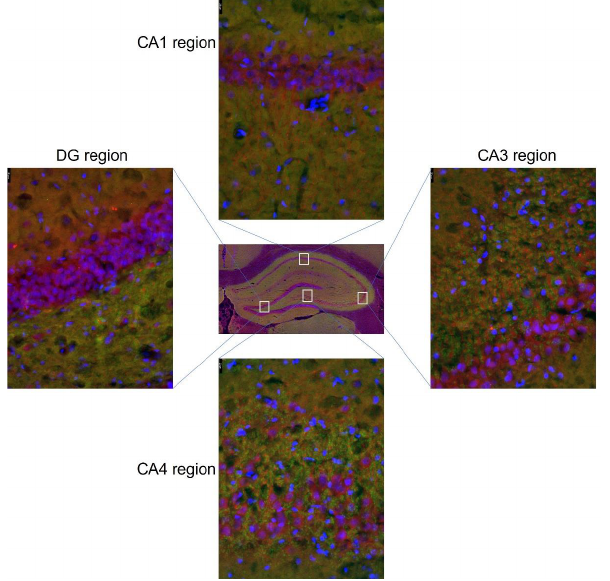
Figure 3. Hippocampal regions used in immunohistofluorescence analysis and their localization on the coronal section. 2.9. Statistical Analysis The data obtained were analyzed using GraphPad Prism 8 software (San Diego, CA, USA). Normality of the distribution was assessed using the Shapiro – Wilk test. The 2-way ANOVA (diet x sex) multiple comparisons with the Benjamini and Yekutieli correction by controlling the False Discovery Rate was used to determine statistical significance. A p < 0.05 was considered significant. * p < 0.05; ** p ≤ 0.01; *** p ≤ 0.001. Results are presented as means ± SEM. 3. Results 3.1. Maternal HSD Increases Extracellular Glu Level in Both Female and Male Offspring The LC/MS/MS method was used to assess the level of Glu in the microdialysis sam- ples. A representative chromatogram is shown in Figure 4B. 2-way ANOVA analysis showed a significant influence of diet on Glu level in the mPFC (F (1,26) = 19.08; p = 0.0002) and the HIP (F (1,26) = 14.91; p = 0.0007). We found significantly increased Glu concentrations in each experimental group compared with its respective control (mPFC females: p = 0.0362; HIP females: p = 0.0209; mPFC males: p = 0.0006, HIP males: p = 0.0061) (Figure 4A). These results prompted us to test the expression of key transporters that maintain the proper level of Glu in the extrasynaptic space, such as EAAT1, EAAT2, VGLUT1, and x c − .